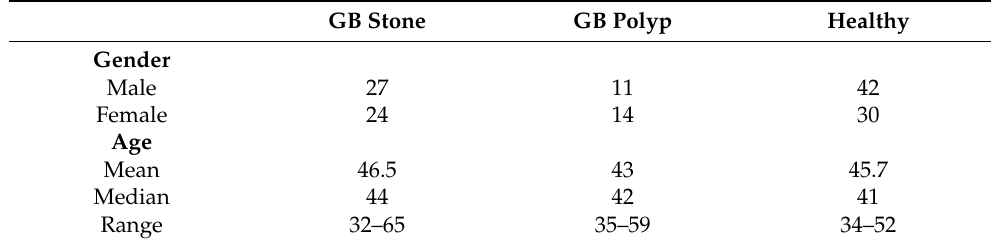
Table 1. Age and gender information of patients with GB stone, GB polyp, and healthy